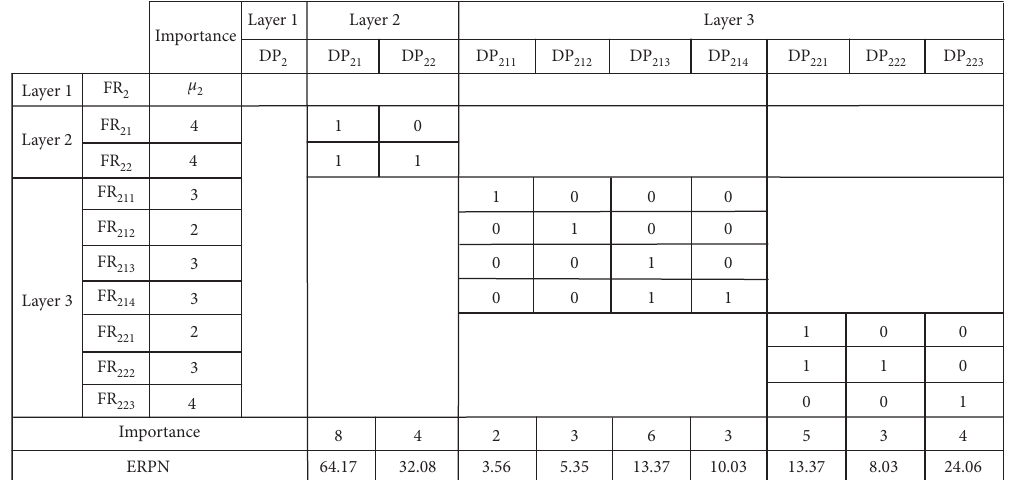
Figure 10: The risk prediction house of quality of DP